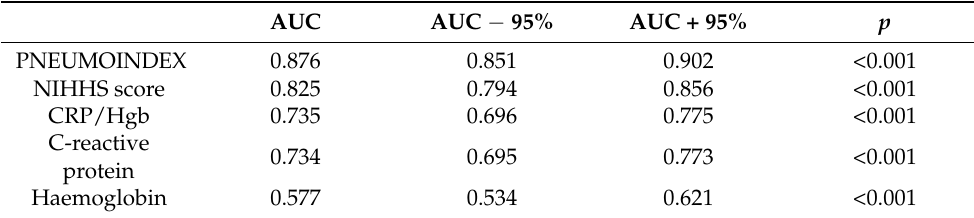
Table 6. Details of the receiver operating characteristics (ROC) analysis for pneumonia.